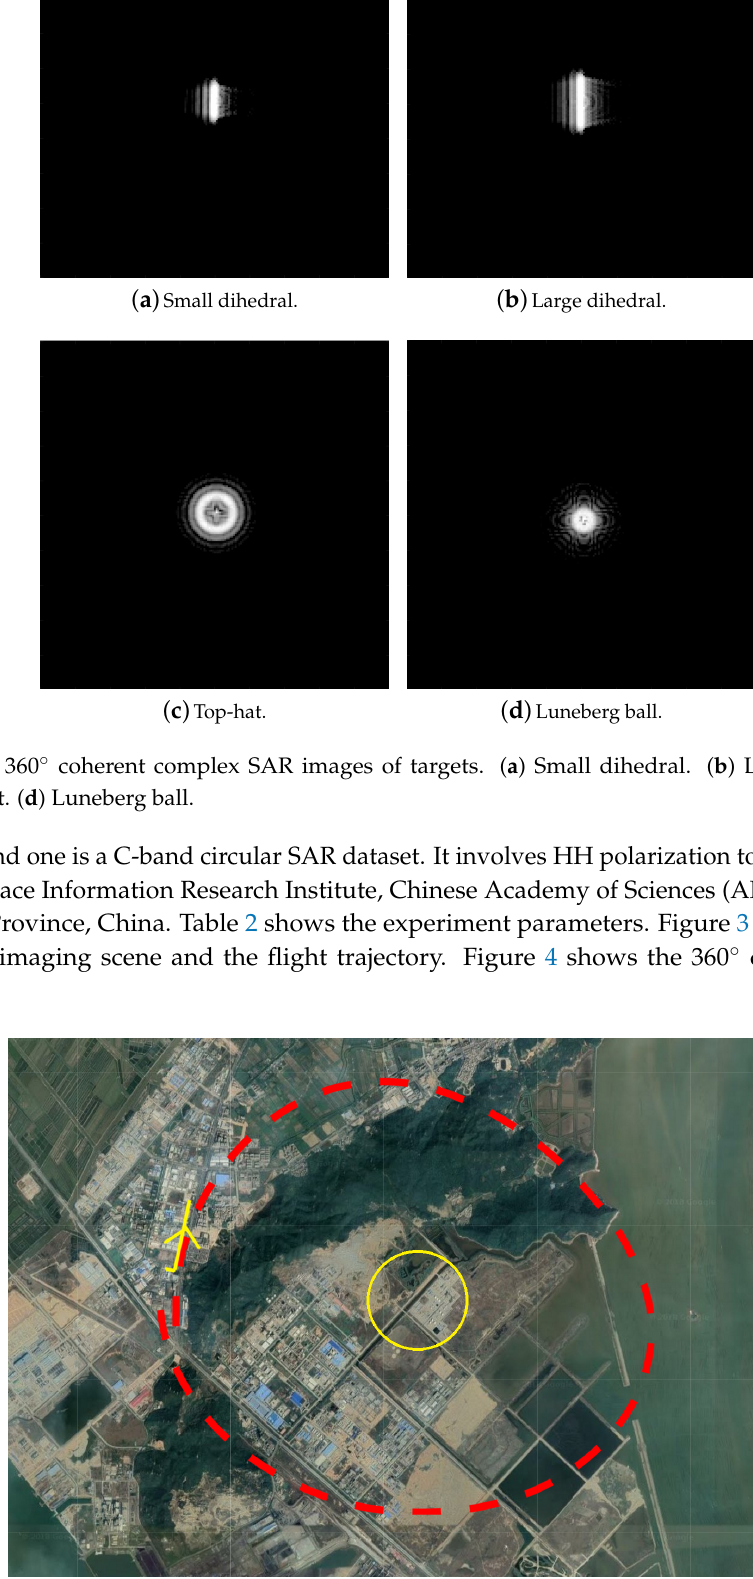
Figure 3. Optical image and the flight trajectory of the C-band circular SAR